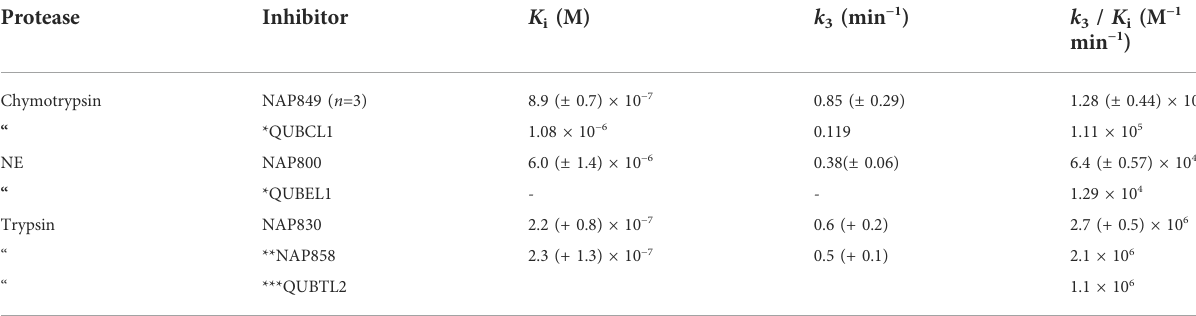
Values are shown as Mean ± SD ( n =2). * Gilmore et al. (2009). ** Ferguson et al. (2022). *** Martin and Walker (2017).